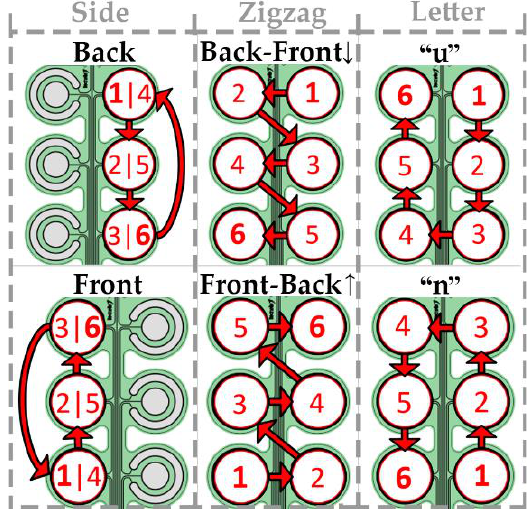
Figure 3. Six movement patterns used in the study. The numbers indicate the order in which the pads were activated. Pads on the right side of the electrode drawing were positioned on the dorsal side of the torso.